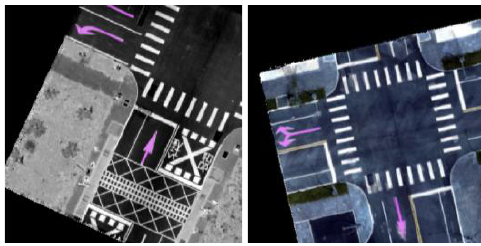
Figure 6. Sample images from the training datasets.